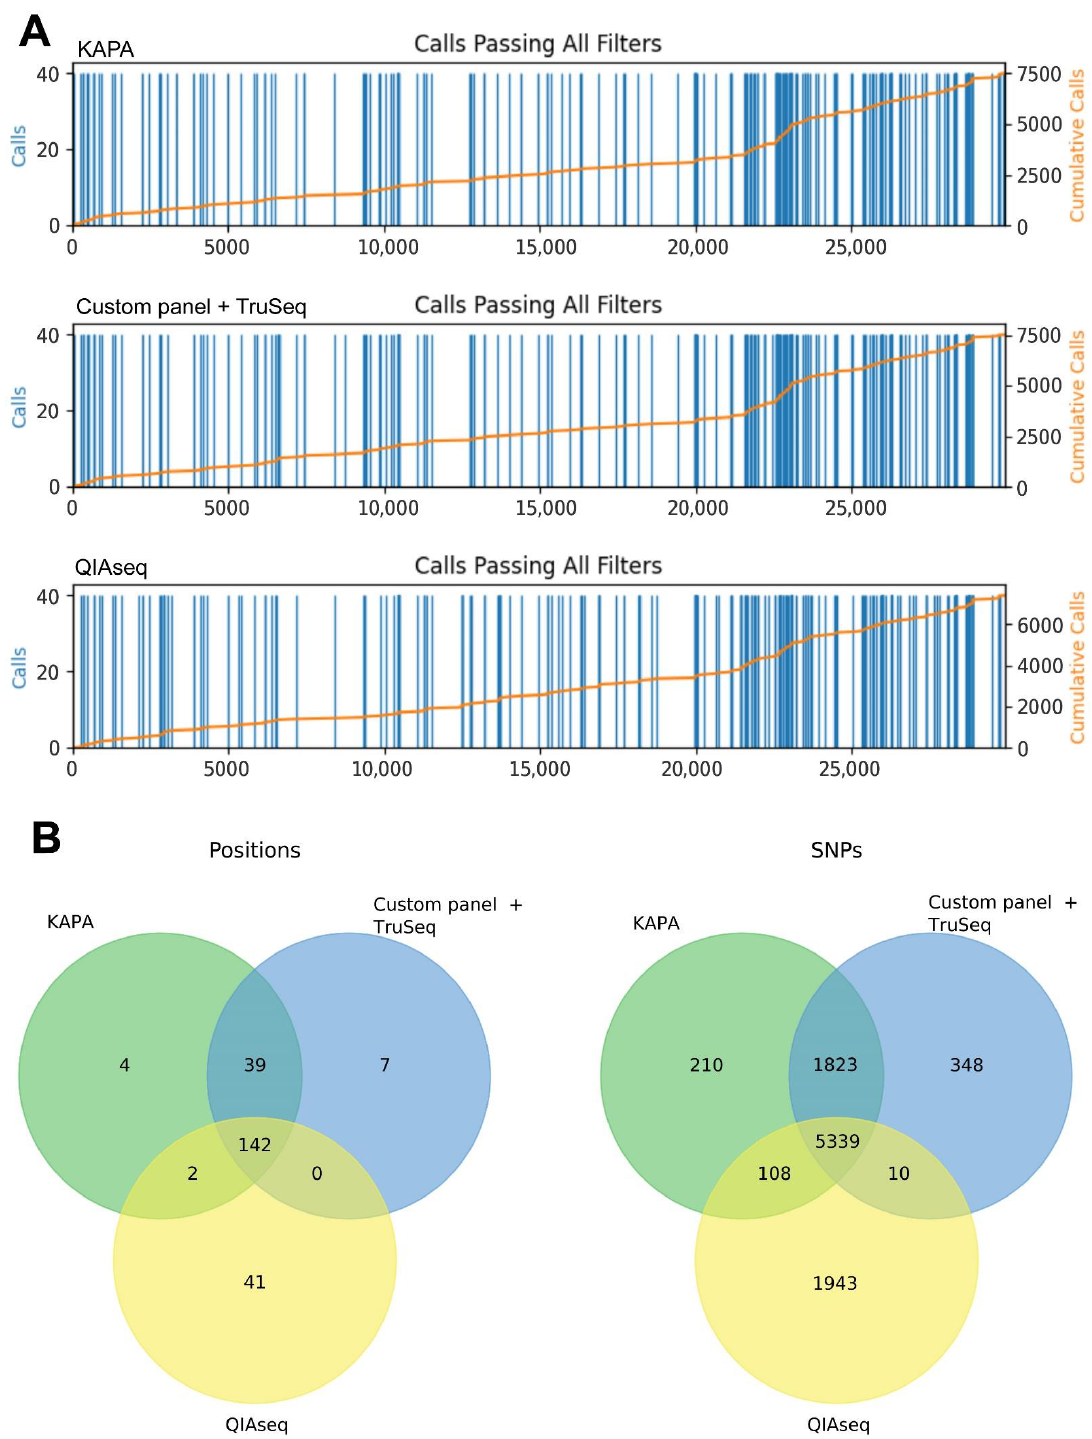
Figure 4. Comparison of SNP detection between different library protocols using all 40 samples. Panel ( A ) shows the presence of SNPs by genomic position (blue bars). The x -axis shows genomic position; the y -axis shows SNP calls. The height of the bars indicates the number of samples having calls at each position (left y -axis). The orange line shows the cumulative sum of variants along the length of the genome. Top—KAPA HyperCap SARS-CoV-2; middle—TruSeq DNA Nano Library Kit with custom primer panel; bottom—QIAseq DIRECT SARS-CoV-2. Panel ( B ) shows Venn diagrams showing the intersections of precise SNP positions (left) and the number of SNPs (right) between three